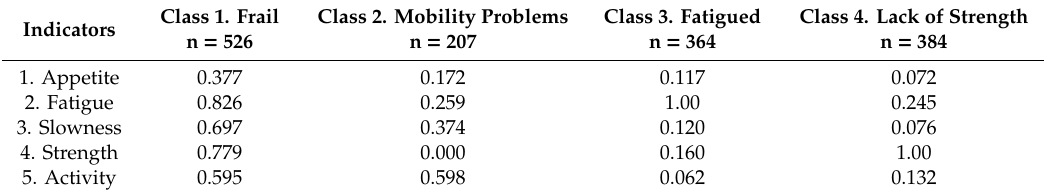
Table 3. Conditional probabilities of the manifestations in each